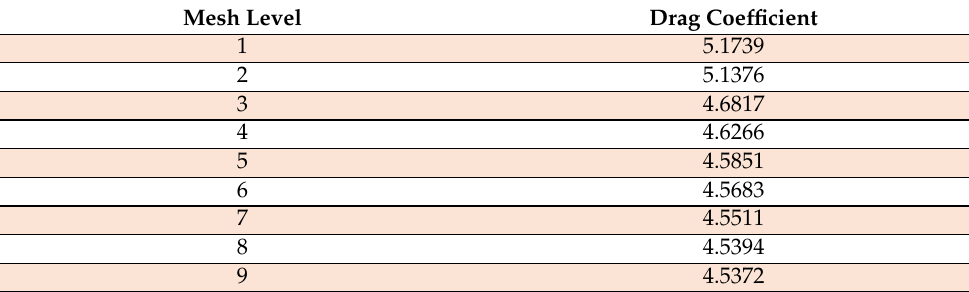
Table 7. Drag coefficient data for Case-IV with LVP.